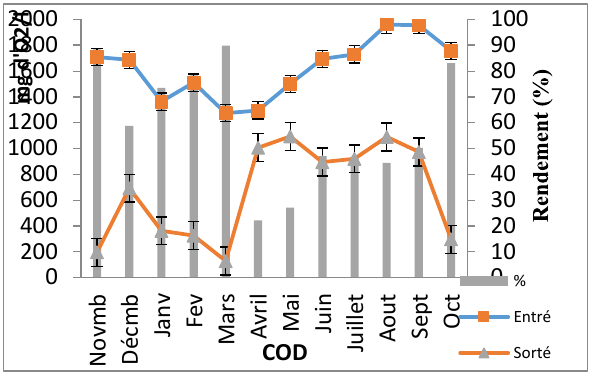
Figure 5. Change in COD values at the entry and exit of the WWTP